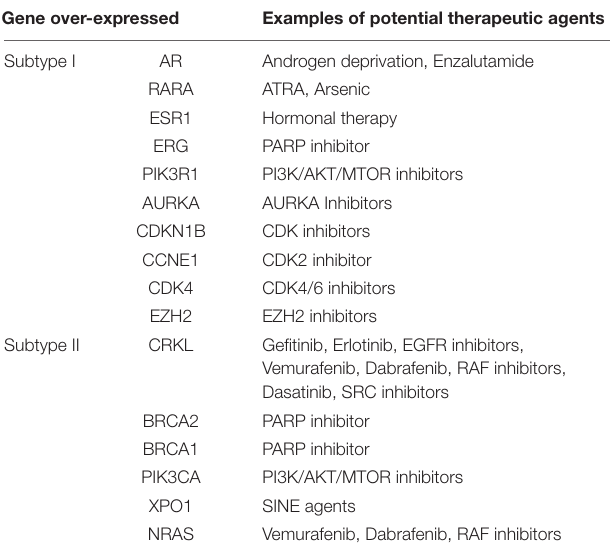
TABLE 2 | Potential target genes enriched in each molecular